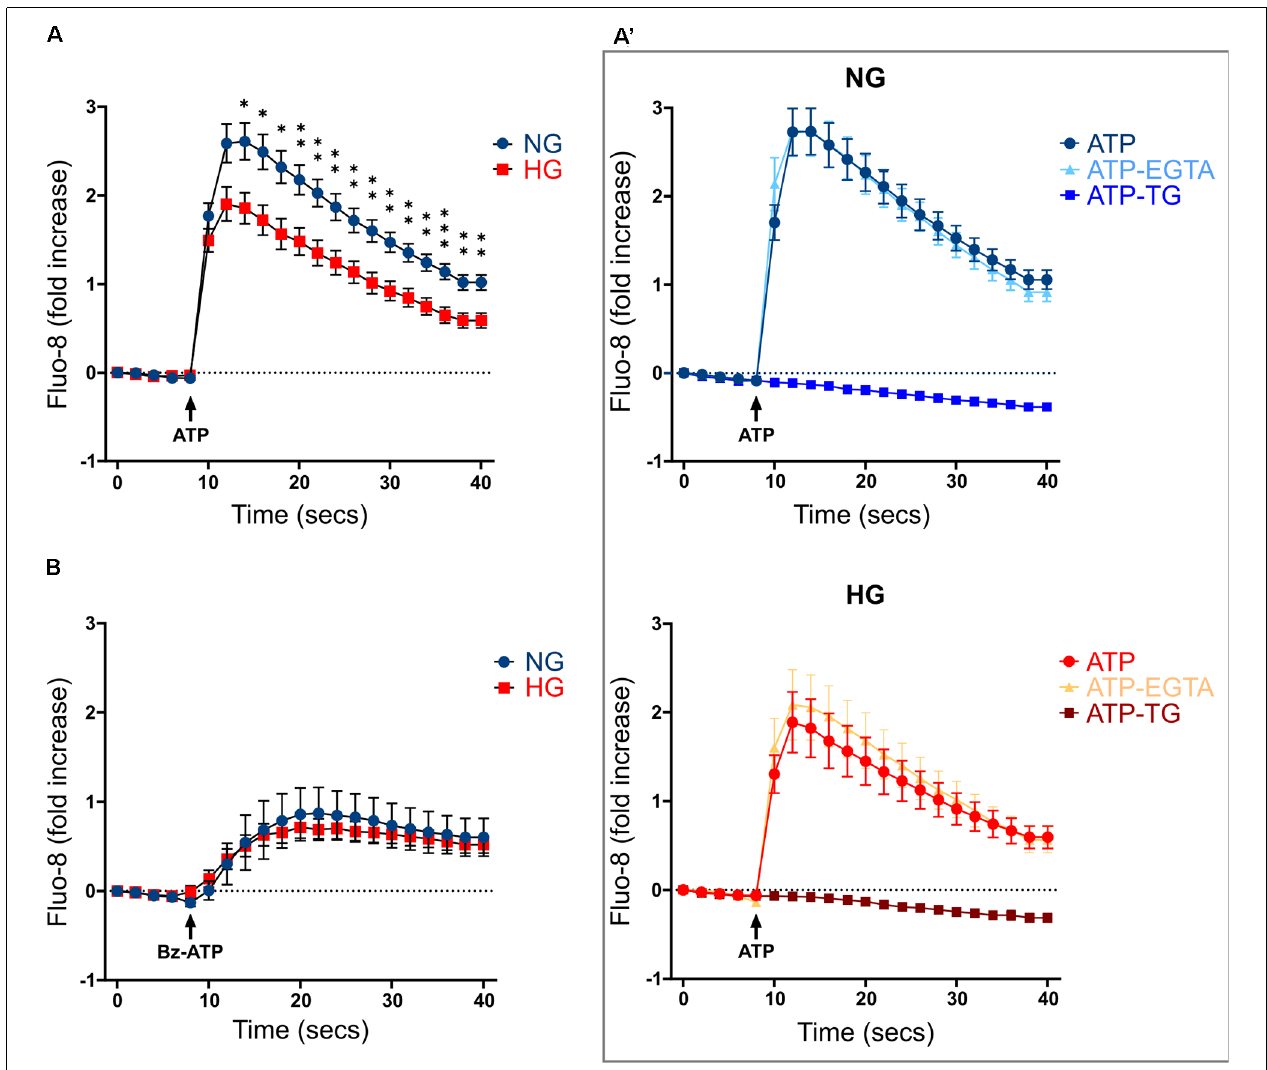
FIGURE 3 | Calcium responses to ATP stimulation in NG and HG. (A) Kinetics of Ca 2+ responses in responding rMC-1 cells following ATP acute stimulation. ATP (100 µ M) was added through an automated liquid handling system to rMC-1 cells after acquiring basal Ca 2+ level images. Values are represented as fold increase with respect to their basal Ca 2+ level. Fold increase values are expressed as mean ± SEM of three independent experiments. Statistical significance is calculated by unpaired two-tailed Student’s t-test ( ∗ p < 0.05; ∗∗ p < 0.005; ∗∗∗ p < 0.001). (A’) Kinetics of Ca 2+ responses in both NG- and HG-maintained rMC-1 cells stimulated with ATP alone or in the presence of either EGTA (3 mM) or thapsigargin (TG, 1 µ M). Stimuli were added to rMC-1 cells through an automated liquid handling system after acquiring basal Ca 2+ level images. Values are represented as a fold increase over their basal Ca 2+ level. Fold increase values are expressed as mean ± SEM of three independent experiments. (B) Kinetics of Ca 2+ responses in rMC-1 cells stimulated with Bz-ATP. Bz-ATP (300 µ M) was added through an automated liquid handling system to rMC-1 cells after acquiring basal Ca 2+ level images. Values are represented as a fold increase over their basal Ca 2+ level. Fold increase values are expressed as mean ± SEM of three independent